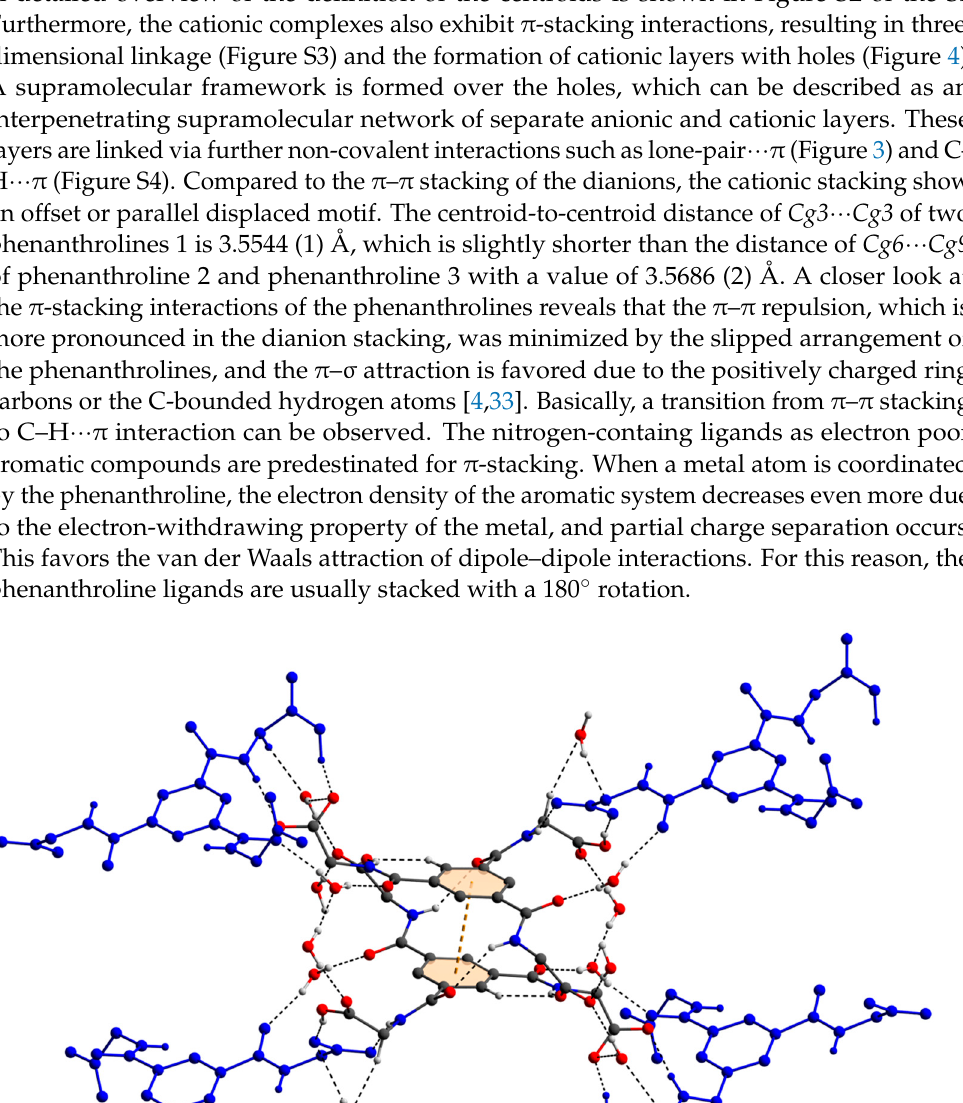
Figure 2. The molecular connections of the dianions in the crystal via hydogen bonds, cooperative hydrogen bonds with attractive secondary electrostatic interactions, and π – π stacking of the anions. The hydrogen atoms which are not involved in hydrogen bonding have been omi tt ed for clarity.